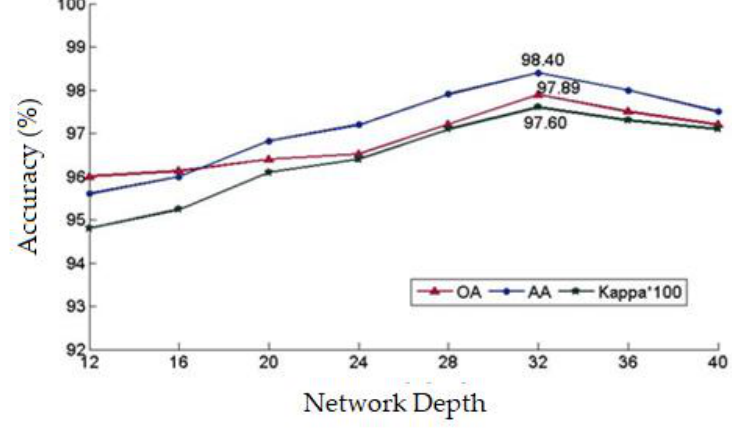
Figure 14. The influence of di ff erent network depths on classification accuracy.